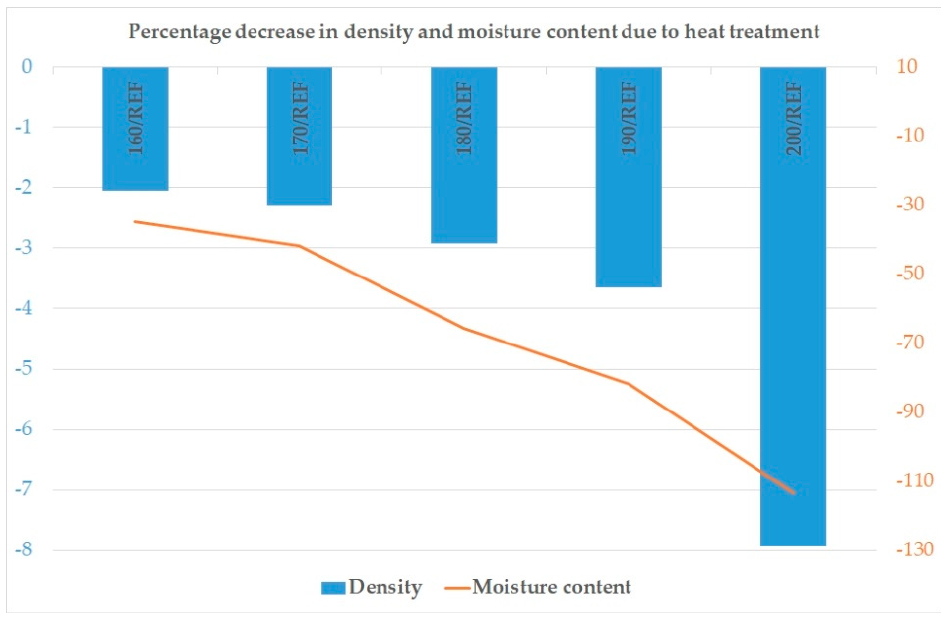
Figure 10. Graphic visualization of the effect of heat treatment temperature to percentage changes of wood density and moisture content. REF = reference, with no treatment; 160 = heat treatment at 160 ° C; 170 = heat treatment at 170 ° C; 180 = heat treatment at 180 ° C; 190 = heat treatment at 190 ° C; 200 = heat treatment at 200 ° C.